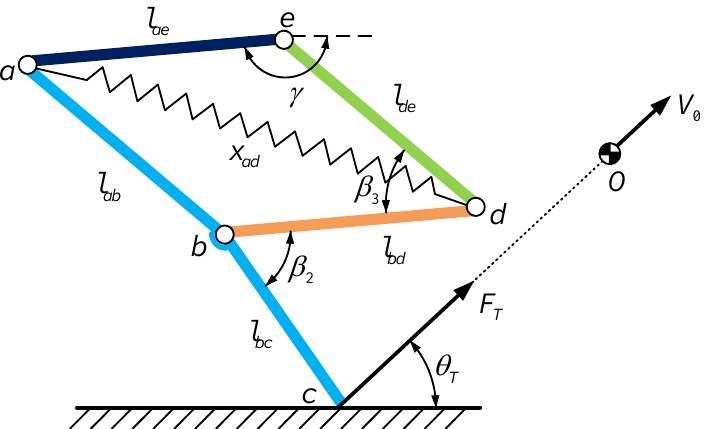
Figure 9. Schematic of structure of hind limbs.